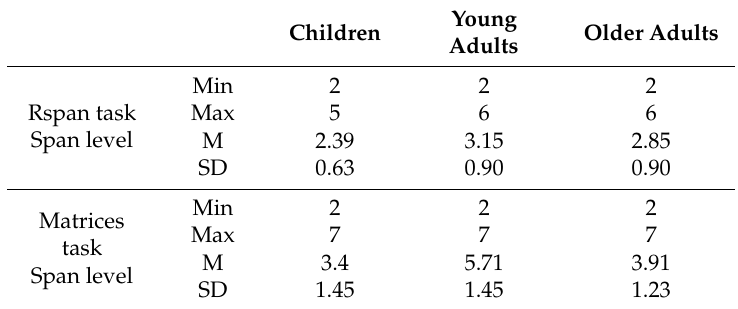
Table A2. Participants’ span level (preliminary phase) by Task and by Age Group.